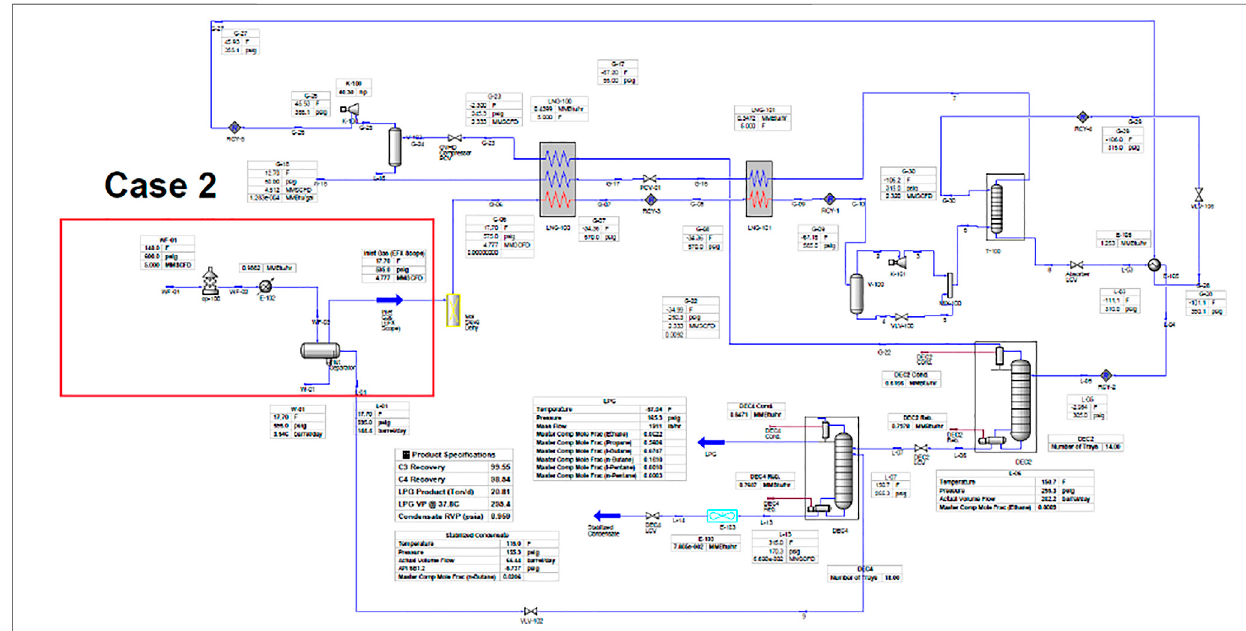
FIGURE 4 | Process fl ow diagram and Aspen HYSYS model for case study